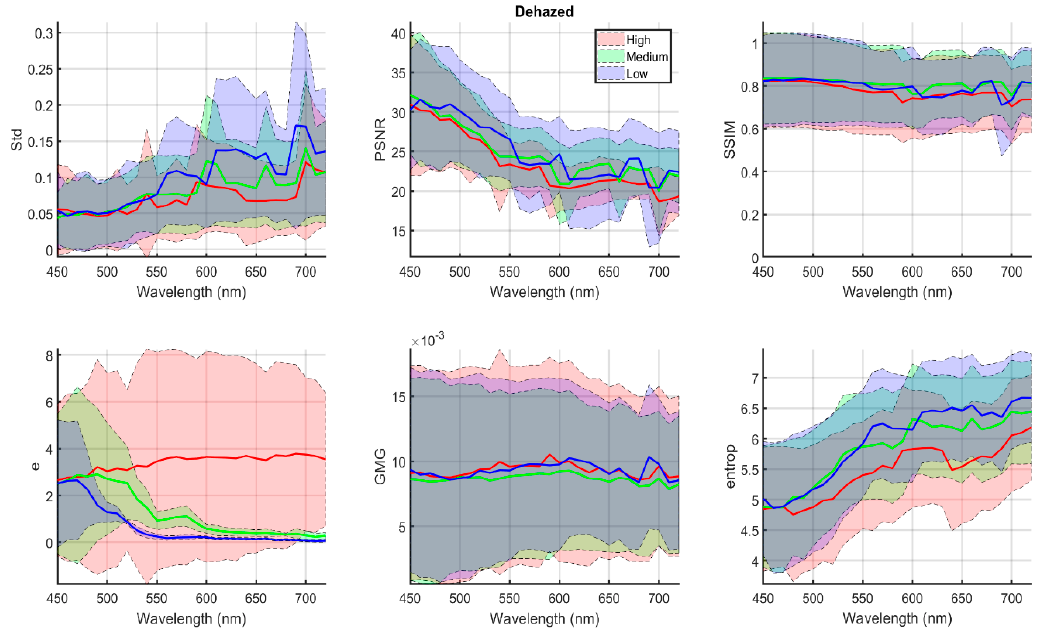
Figure 5. Quality metric values for the dehazed images (average of the five algorithms used for dehazing) corresponding to low (blue), medium (green) and high (red) haze conditions, in the full wavelength range from 450 nm to 720 nm. The shadowed areas correspond to plus/minus one standard deviation around the average results for each metric.